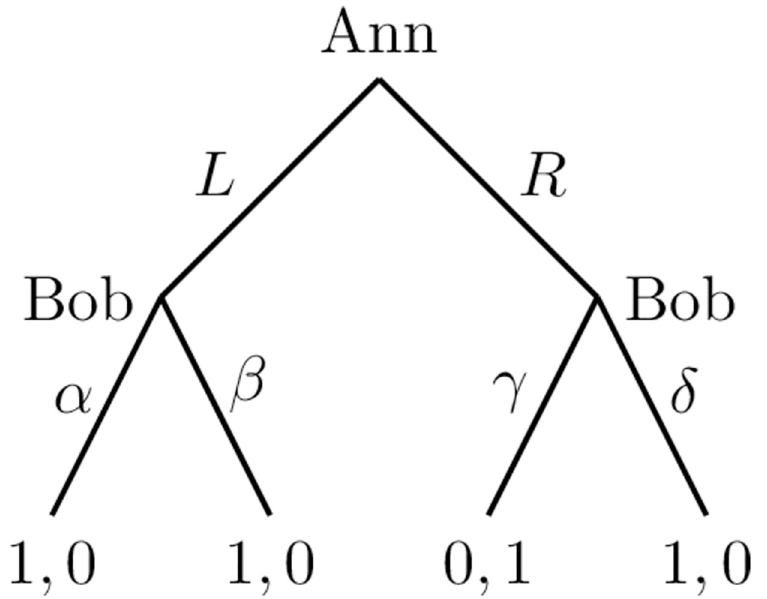
Fig 2. Zero-sum payoffs and belief in opponent’s